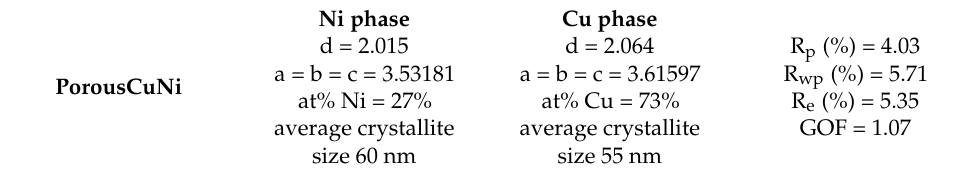
Figure 2. XRD patterns of porous ( a ) and fully dense ( b ) CuNi films in the 40 ◦ − 80 ◦ 2 θ range. I(Cal) and I(Bkg) stands for experimental powder diffraction, Rietveld-refined, and instrumental background data. The black vertical lines represent the Bragg reflection peaks and the I(Obs-Cal) is the differential intensity between I(Obs) and I(Cal). Table 1. Composition of porous and fully dense CuNi film, as determined from XRD